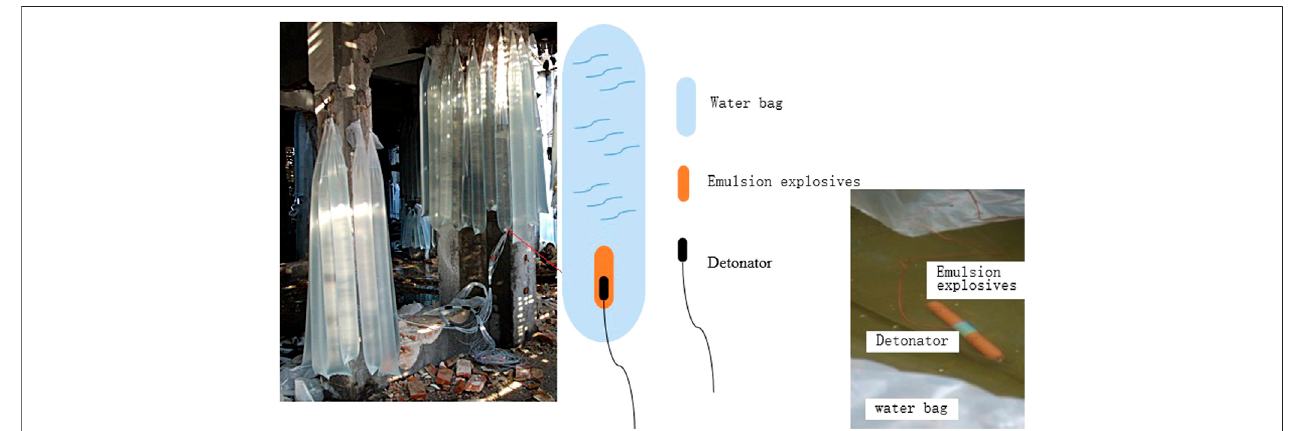
FIGURE 3 | Explosion water mist generation facility scheme for BDD suppression in blasting demolition